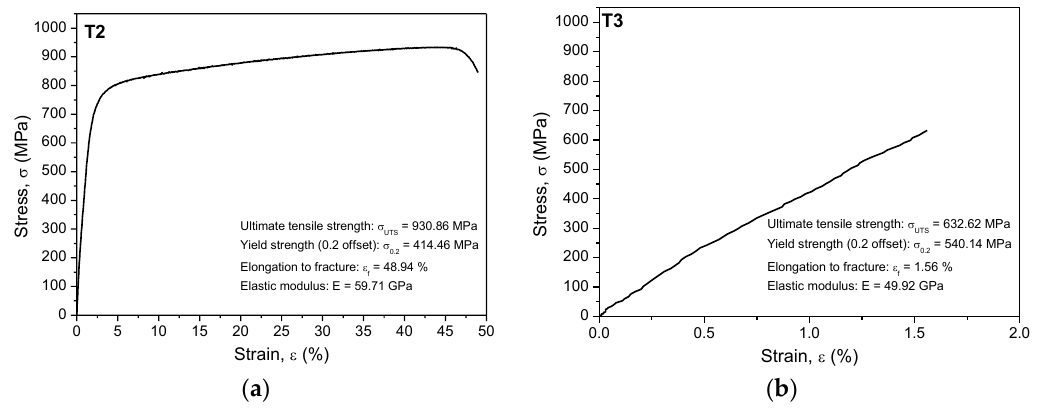
Figure 3. Stress-strain curves for ( a ) TiNbZr cast (T2) and ( b ) annealed (T3) alloys; the presented results are only for one of replicate.